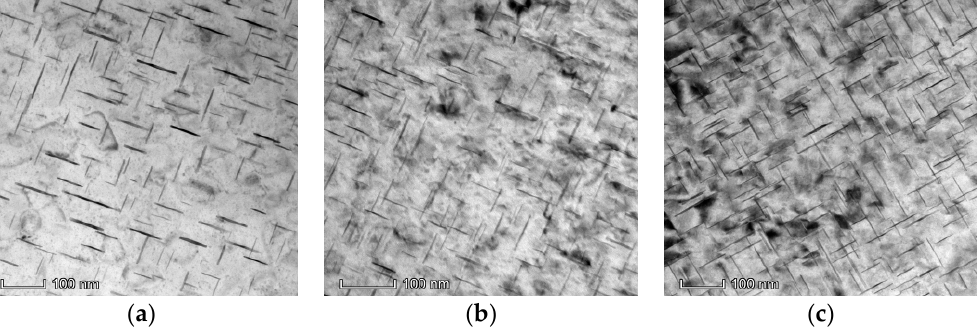
Figure 7. TEM of ZCL205A alloy deposits manufactured with different deposition processes at room temperature after peak aging. ( a ) The TEM image of a sample prepared using CMT process; ( b ) the TEM image of a sample prepared using CMT and Pulse process; and ( c ) the TEM image of a sample prepared using the CMT Pulse and Advanced process.